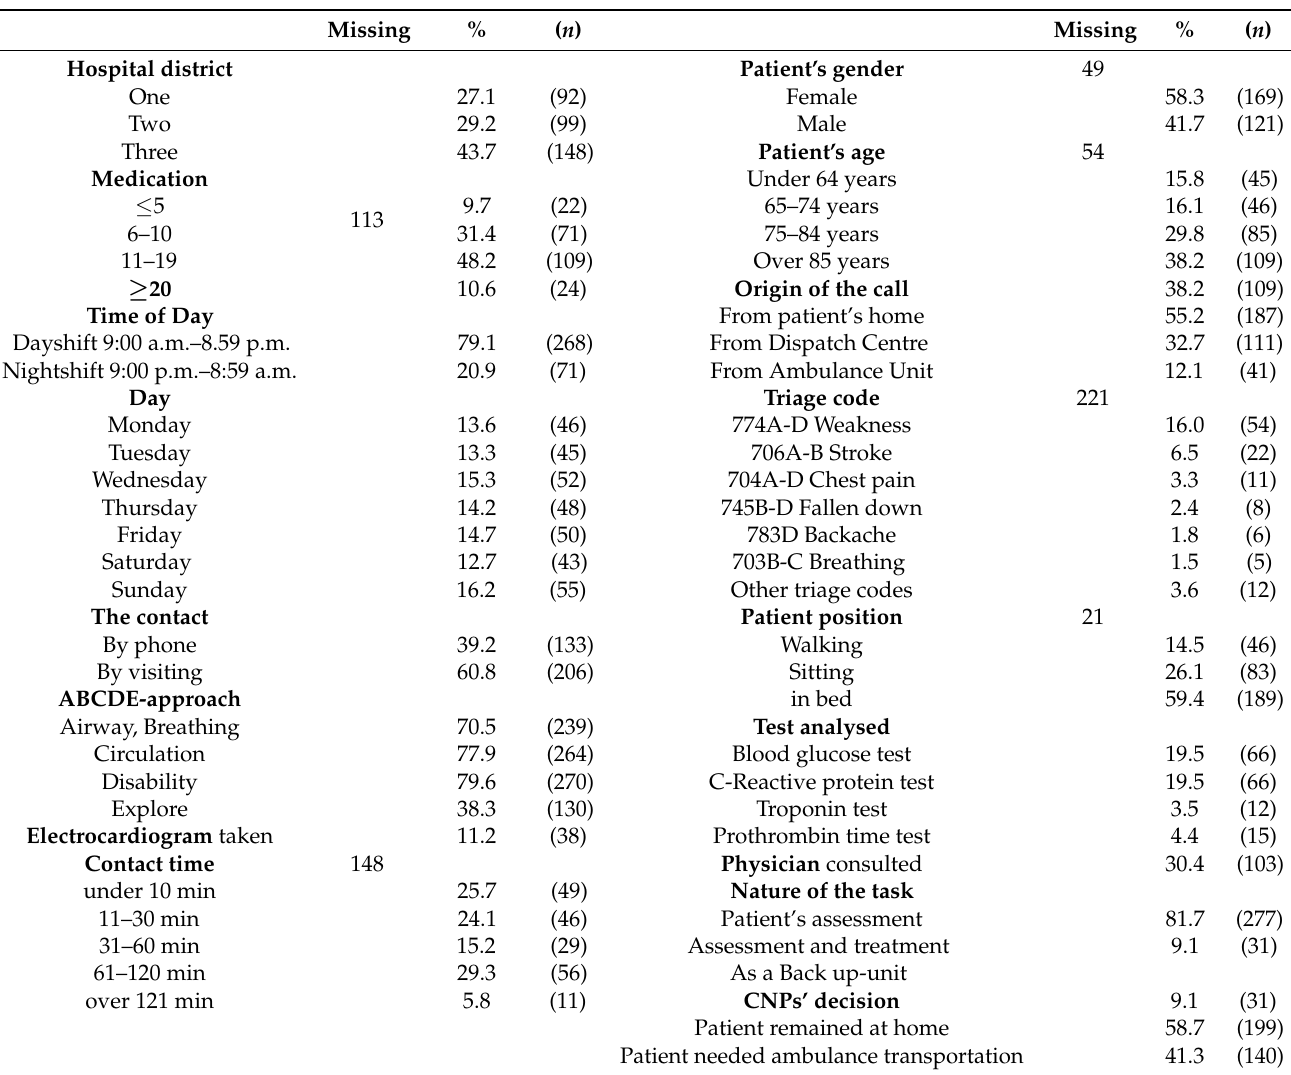
Table 2. Demographic characteristics of the 339 CP